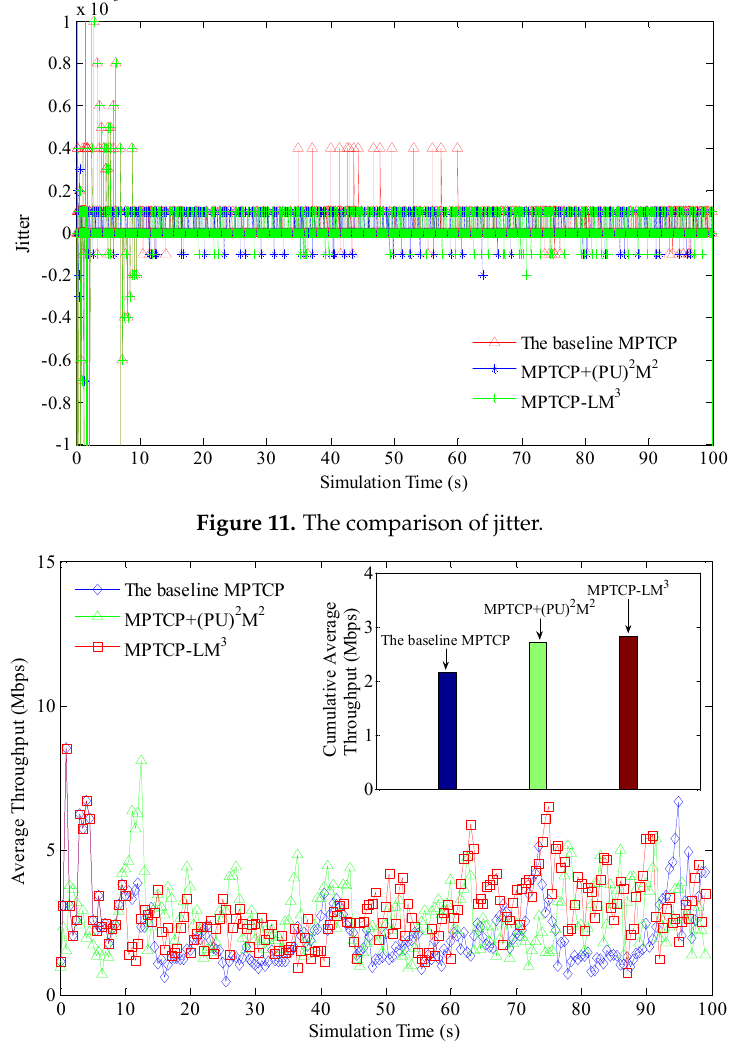
Figure 12. The comparison of